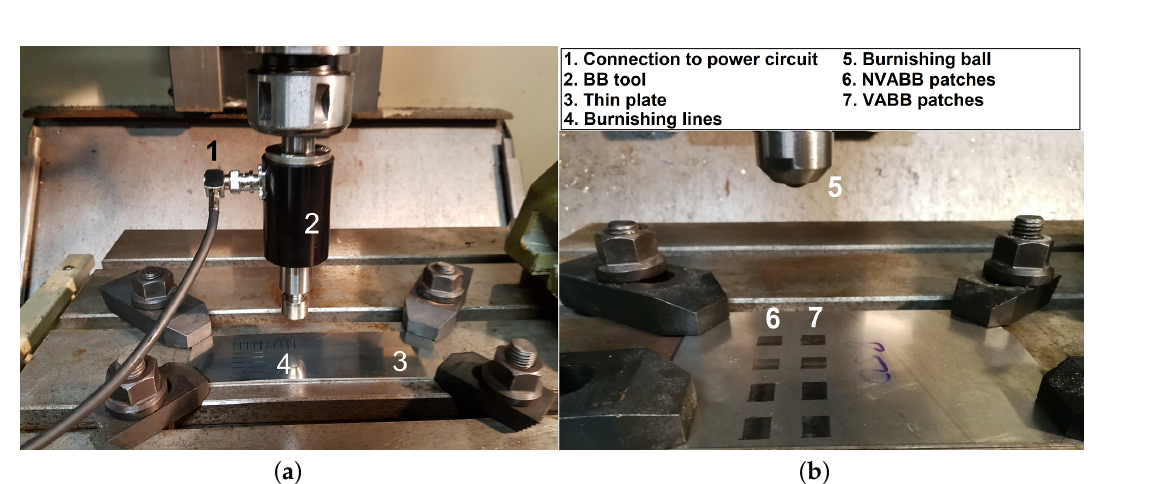
Figure 1. ( a ) Experimental setup of the ultrasonic vibration-assisted ball burnishing (UVABB) experiment. ( b ) Eight patches performed on the plate with a 10 wt.% of pre-existing martensite during phase